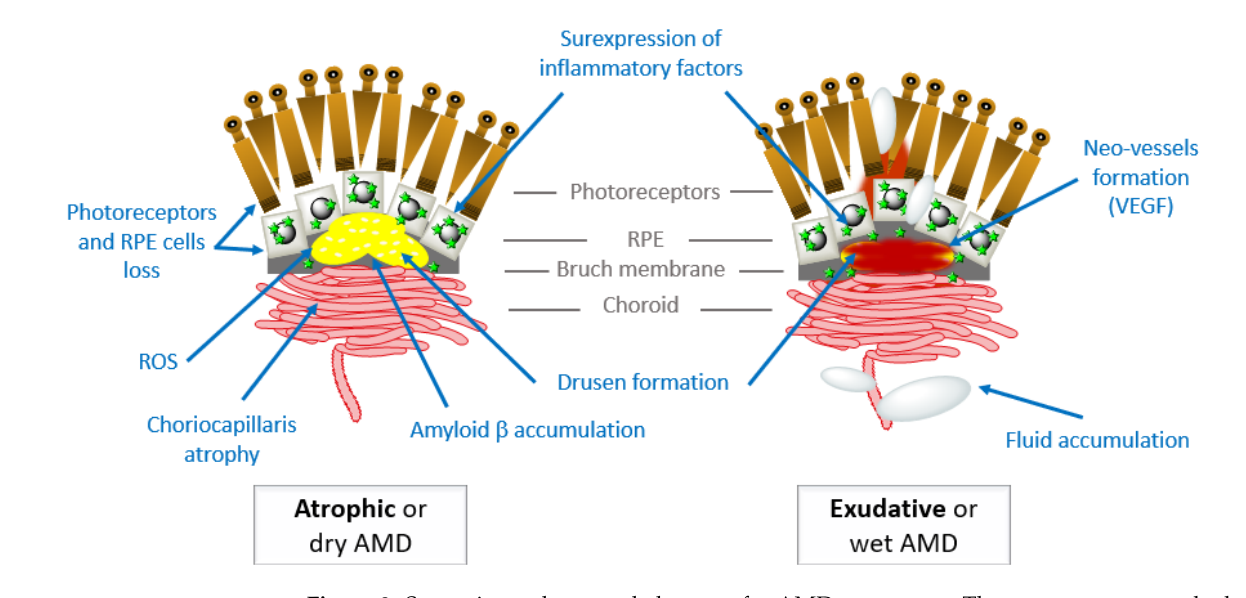
Figure 8. Strategies and targeted elements for AMD treatments. The treatments target the loss of photoreceptors/RPE cells; ROS accumulation; choroid atrophy; inflammatory factors; β -amyloid; drusen formation; neovascularization and vascular leakage.